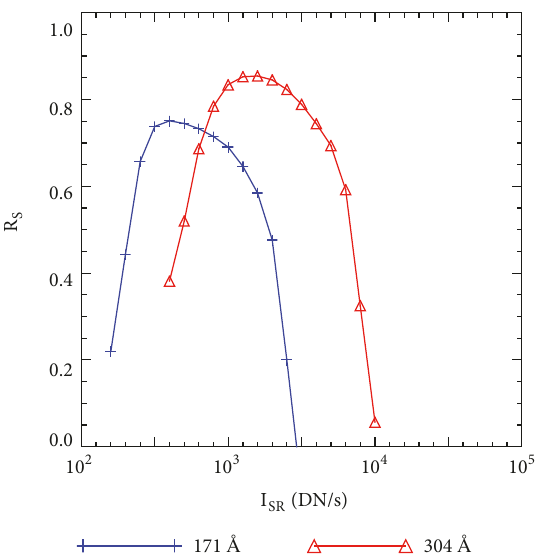
Figure 1: The Spearman correlation coefficients (R S ) between F